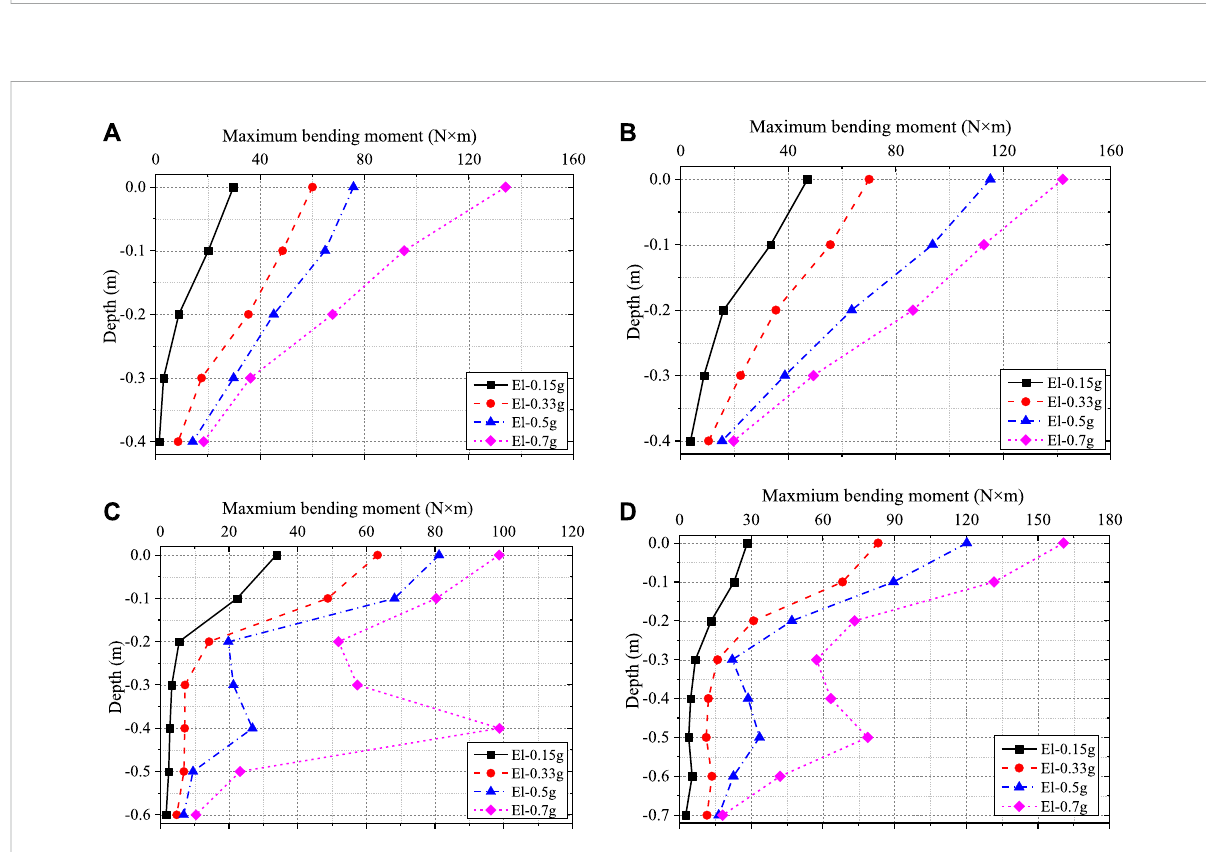
FIGURE 11 Peak bending moment of the piles beneath disposal containers: (A) 3#-P1; (B) 3#-P2; (C) 5#-P1; (D) 5#-P2 with general moisture content.